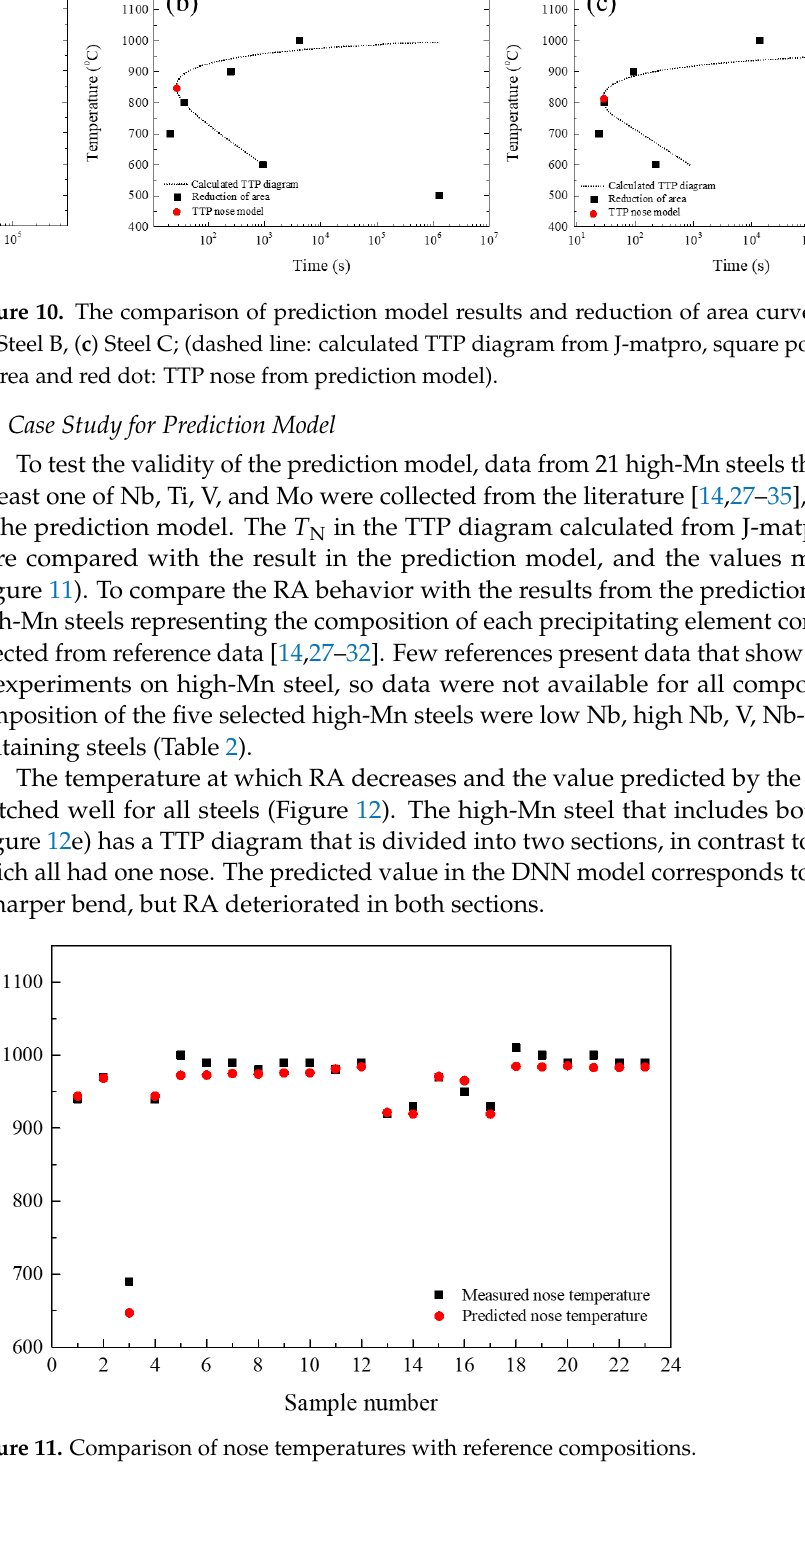
Figure 9. A prediction result of nose temperature with two datasets.